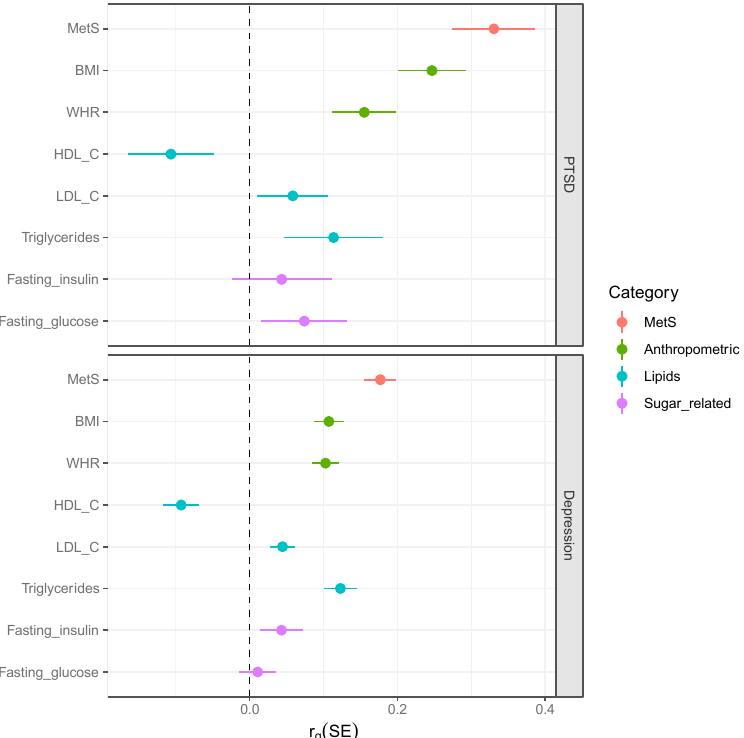
Figure 3. Genetic correlation estimates between MetS and its components with PTSD (top) and depression (bottom). The bars correspond to standard errors (SE) and the genetic correlation estimates (r g ) are represented by a dot in the middle of the SE bars.